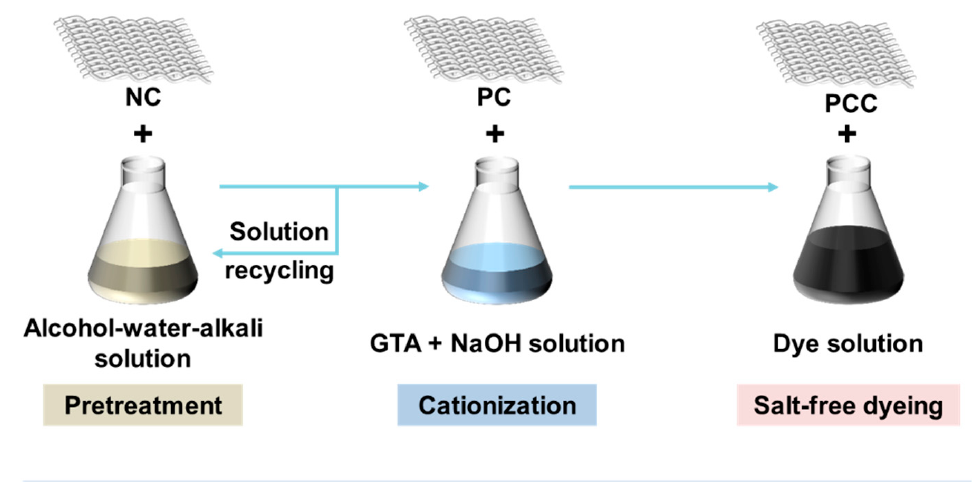
Figure 2. Schematic diagram of the pretreatment, cationization, and salt-free dyeing process of natural cotton fiber.